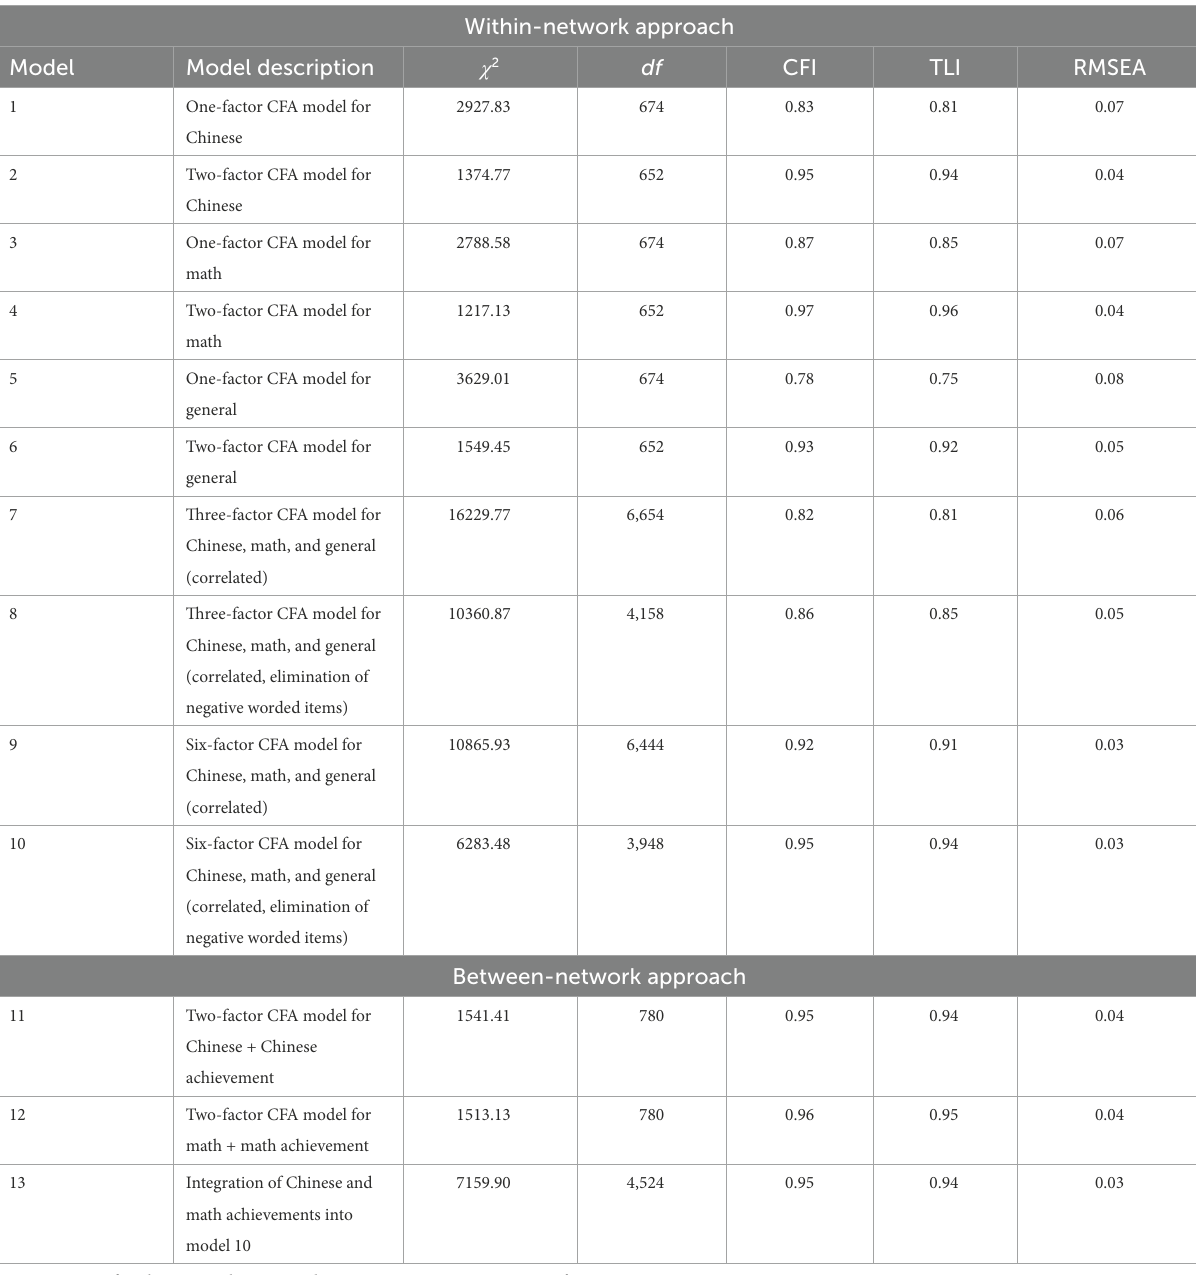
TABLE 1 Goodness of fit of CFA models.